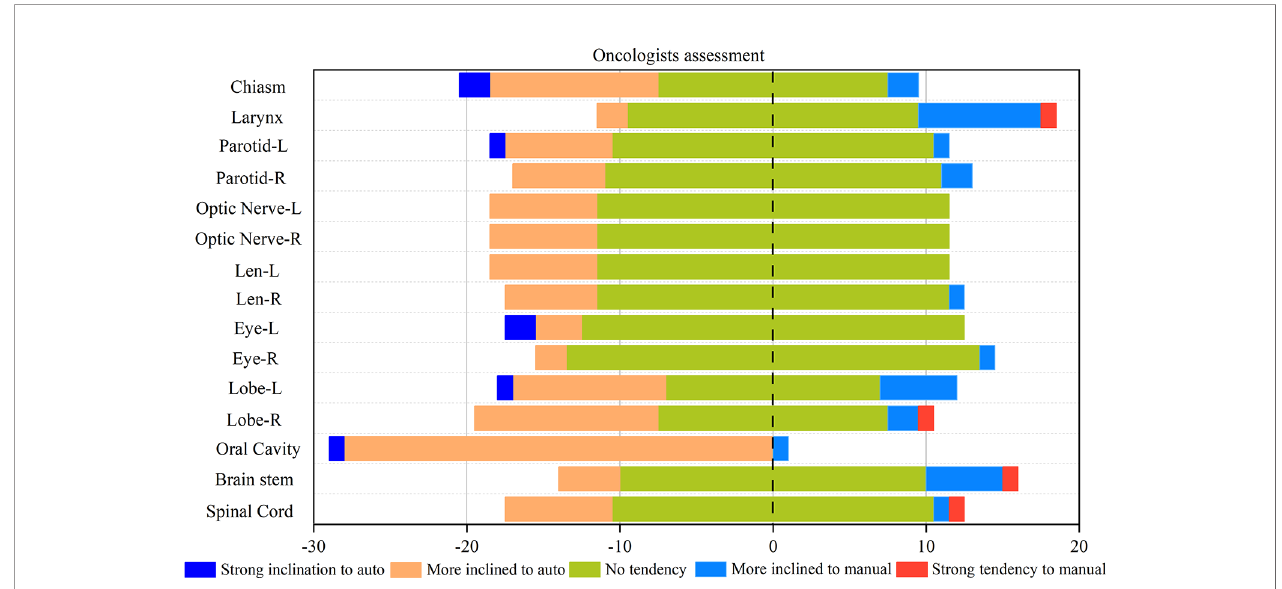
FIGURE 4 | Rates of correct and incorrect classi fi cation of contours as human or automatically